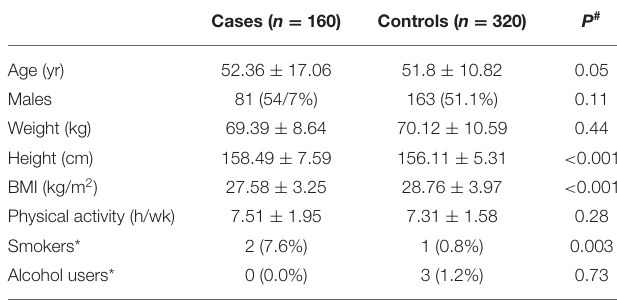
TABLE 1 | Characteristics of the